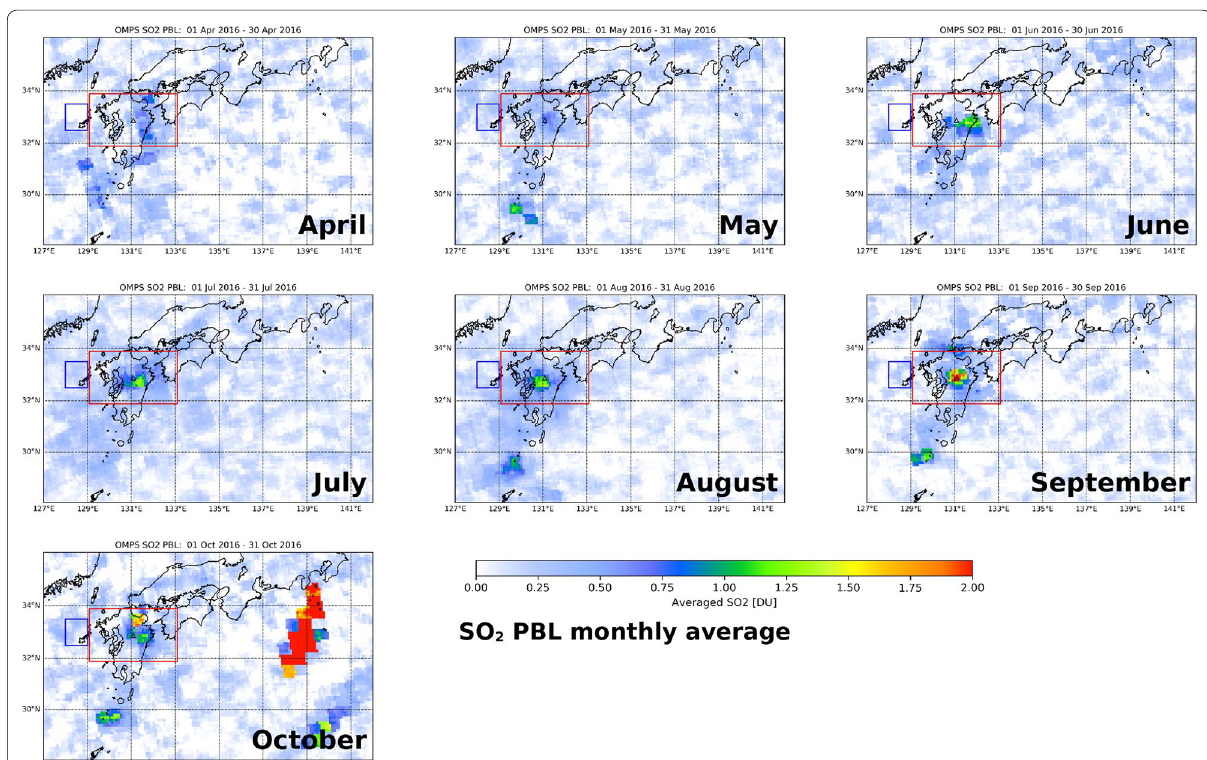
Fig. 4 Maps of the monthly averaged SO 2 PBL VCDs measured by OMPS from April to October 2016. The triangle and the red and blue rectangles are as same as those in Fig. 3. The high SO 2 VCDs around 140°E in longitude found in October map correspond to the SO 2 cloud by the 8 October